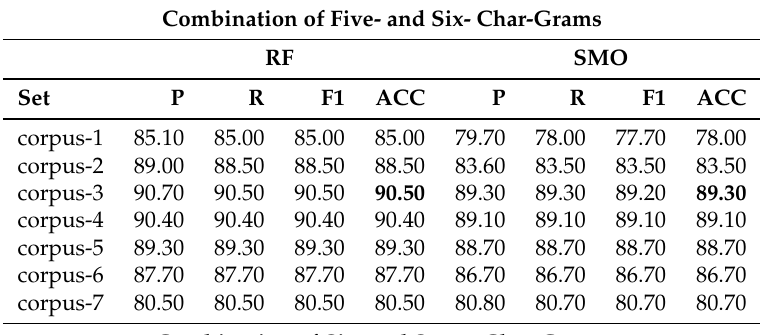
Figure 9. Comparison of the accuracy between five-, six-, seven- and eight-char-grams for the SMO classifier. Table 6. Results using pair combinations of fixed-length characters for the char-gram